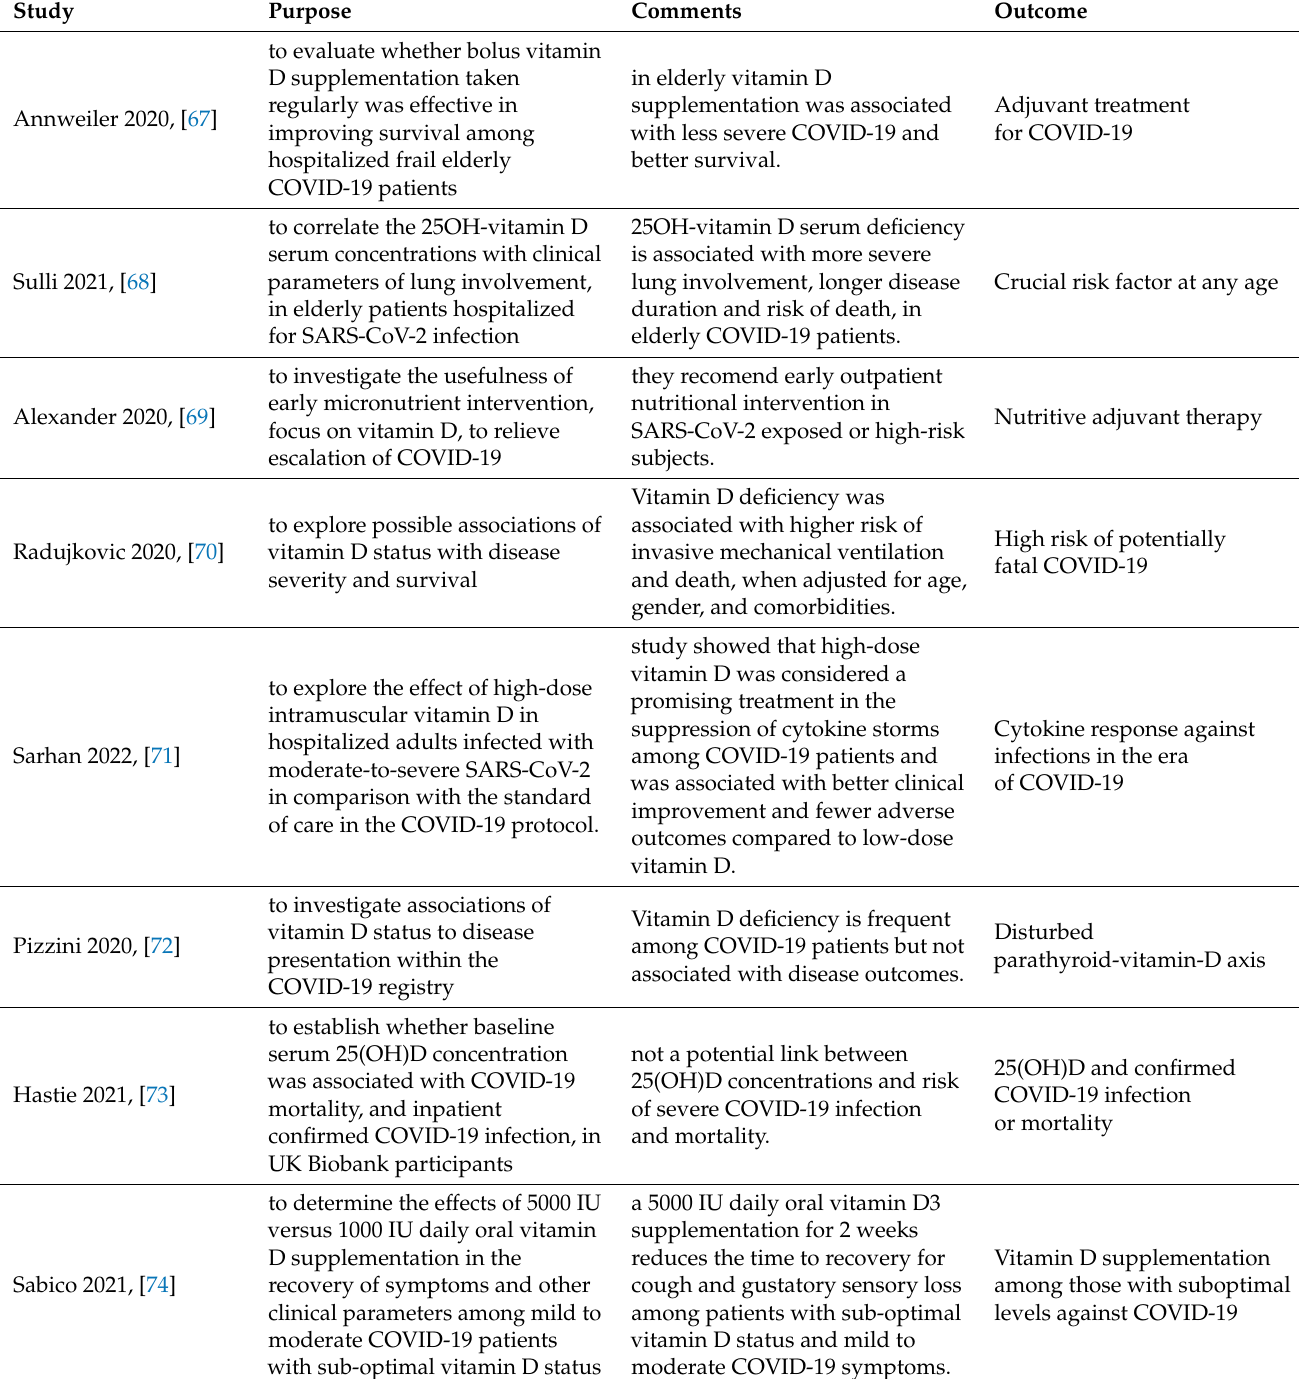
Table 2. Relationship between vitamin D and